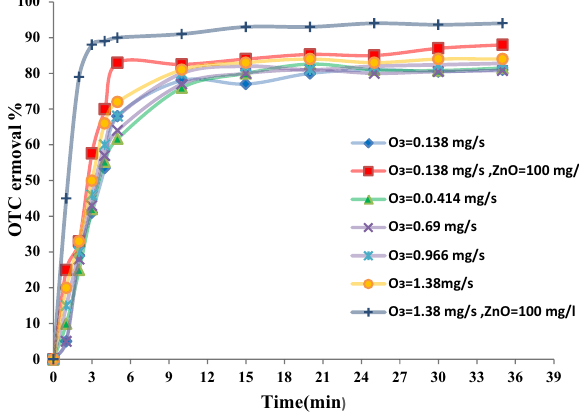
Fig. 6 The effect of ZnO dosage with time on the removal effi- ciency of OTC (OTC conc. = 50 mg/l, pH = 7, ozone generation rate = 1.38 mg/s, at room temp.)